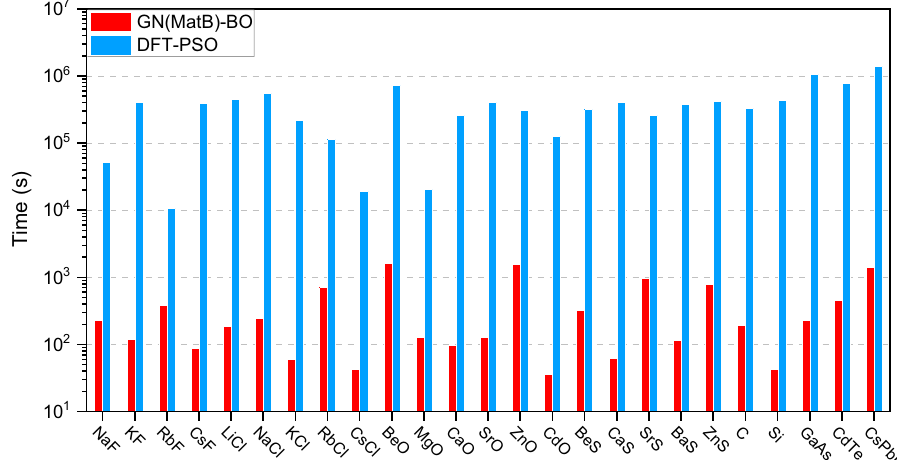
multiple combinations of database, GN model, and optimization algorithm showed that GN model trained on MatB combined with Bayesian optimization structural searching [GN(MatB)-BO], although with less accuracy than DFT results, can predict crystal structures with computational cost three orders of magnitude less than DFT-based approaches. Meanwhile, the limitations of the current GN-OA approach are also apparent. In terms of meth- odology, several directions need further development, including crystal structure characterization, structural searching, and algo- rithm parallelization, to predict more complicated and unknown structures more ef fi ciently. The current study may open a new avenue for data-driven crystal structural prediction without using the expensive DFT calculations during structural searching. Data availability